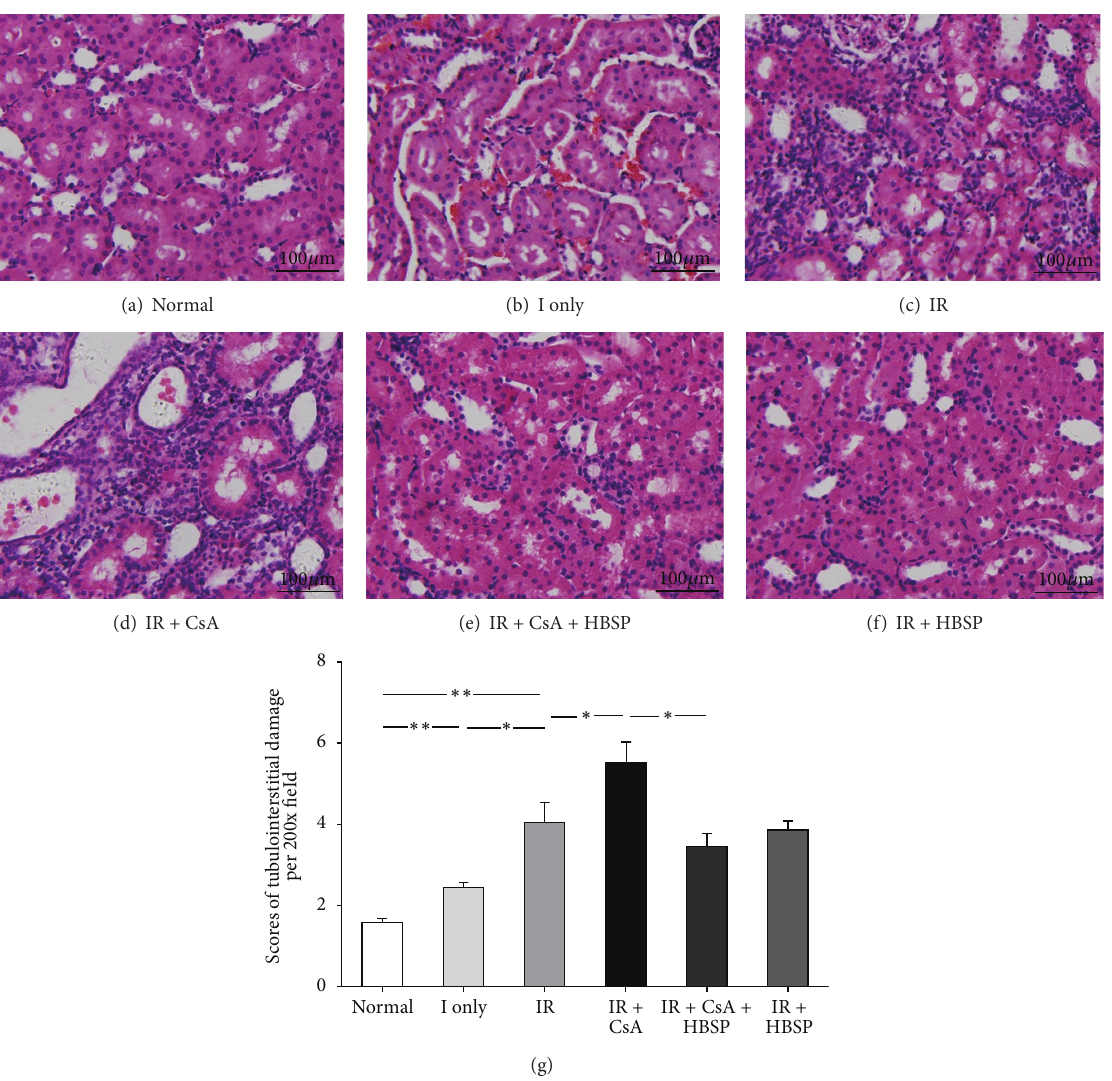
Figure 2: TID was assessed in H&E stained sections. Tubular dilation, epithelial cell vacuolation, interstitial expansion with edema or inflammation, and cells or cell debris in tubular lumens were mainly seen in IR kidneys and kidneys exposed to CsA (a–f). Semiquantitative scores revealed that the score of TID was significantly higher in the CsA exposed IR kidneys but reduced by HBSP (g). Data are expressed as mean number in the high power field of each group (mean ± SEM; 𝑛 = 6 ). ∗ 𝑃 < 0.05 ; ∗∗ 𝑃 < 0.01 .